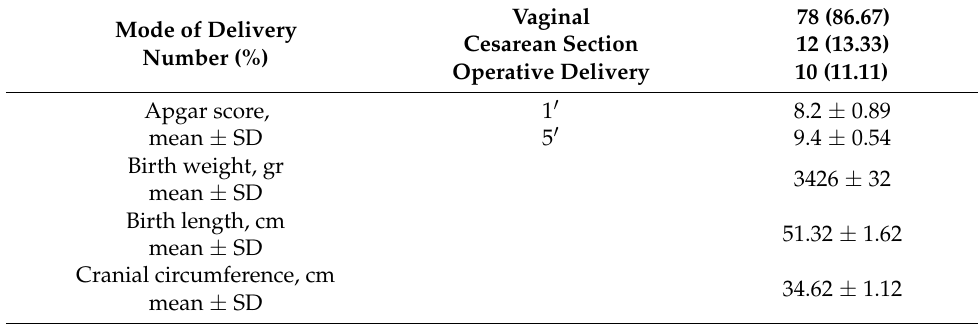
Table 3. Delivery data of the study